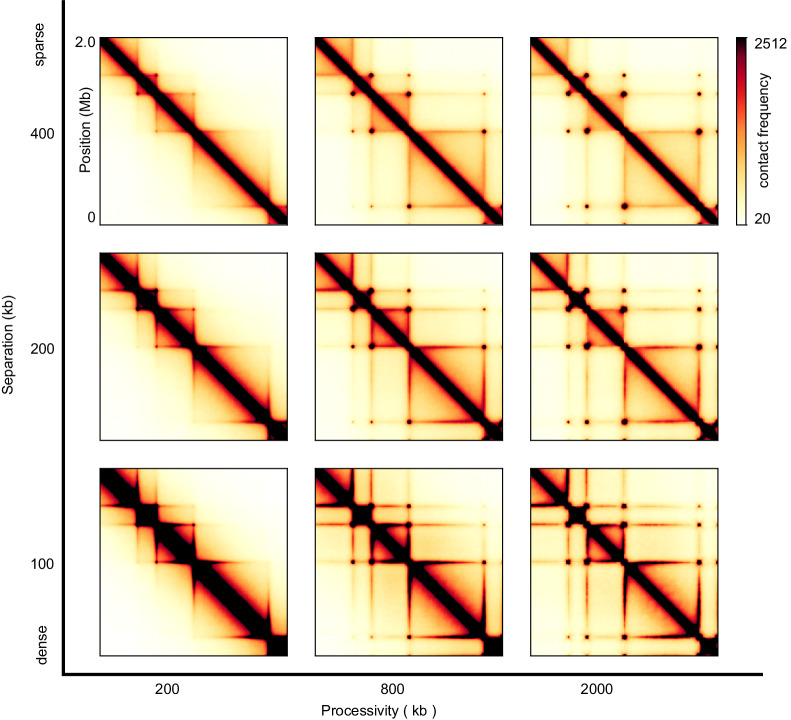
Sweep of the separation and the processivity of LEFs for two-sided LEFs.The TAD sizes from left to right are 200 kb, 400 kb, and 800 kb respectively.